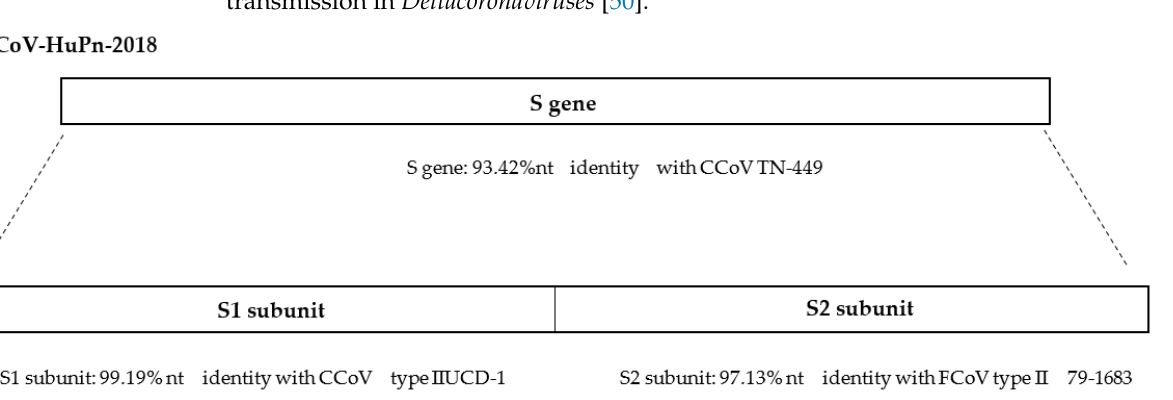
Figure 2. Nucleotide (nt) identity (%) of the CCoV-HuPn-2018 S gene with CCoV type II and FCoV type II [47].